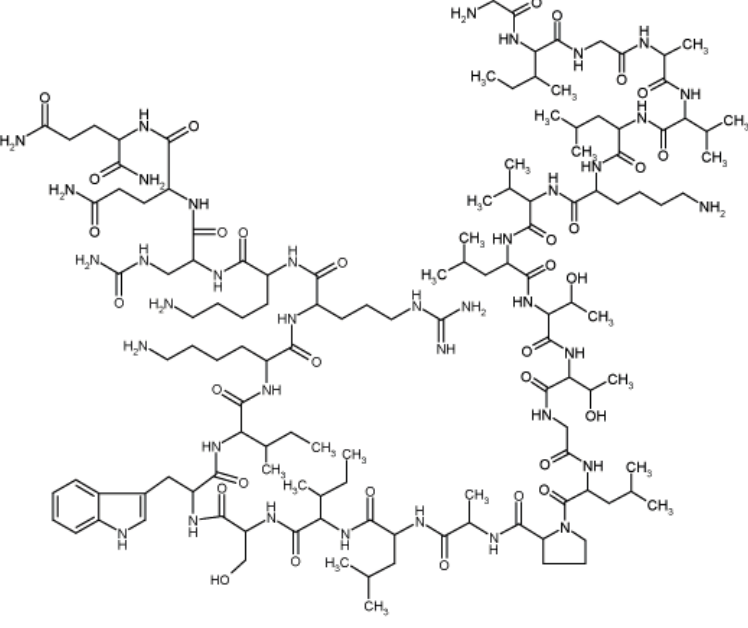
Figure 1. Chemical structure and amino acid sequence of bee